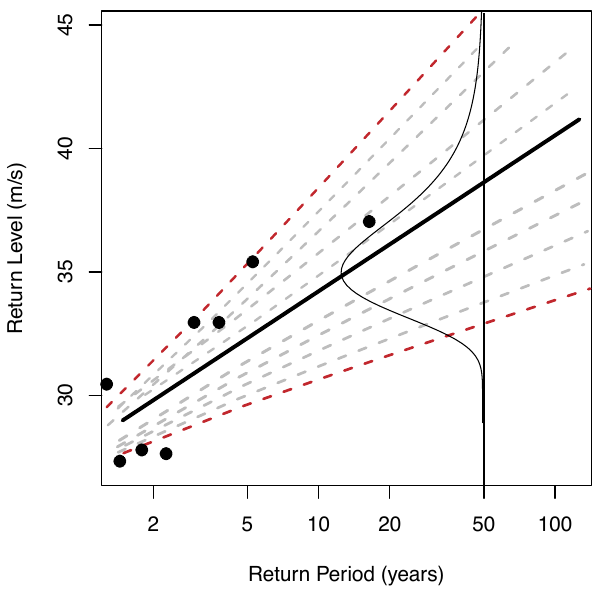
Figure 2. Return level–return period plot of a random configuration as an example. The estimated return levels are given by the solid black line, and the dashed lines represent the confidence intervals (40th–60th, 30th–70th, 20th–80th, 10th–90th and 5th–95th, in red). The empirical return levels (black points) are also represented.The thin black curve indicates the shape of the corresponding probability density function calculated based on the distribution of confidence